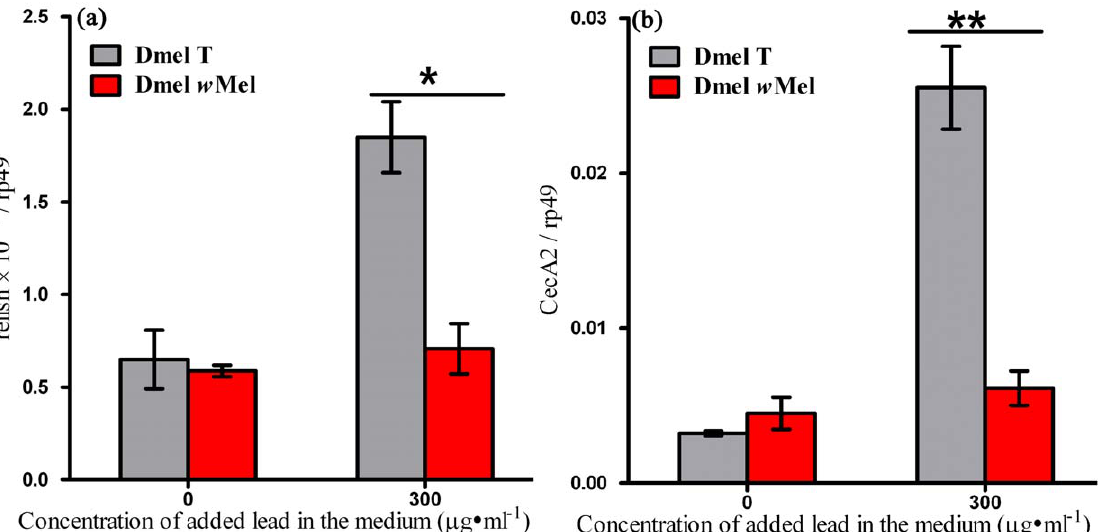
Figure 5. Effect of Wolbachia on the expressions of relish (a) and CecA2 (b) genes in Drosophila larvae cultured in Pb-contaminated medium. Bars=standard error; ‘‘*’’ indicated P , 0.05; ‘‘**’’ indicated P ,